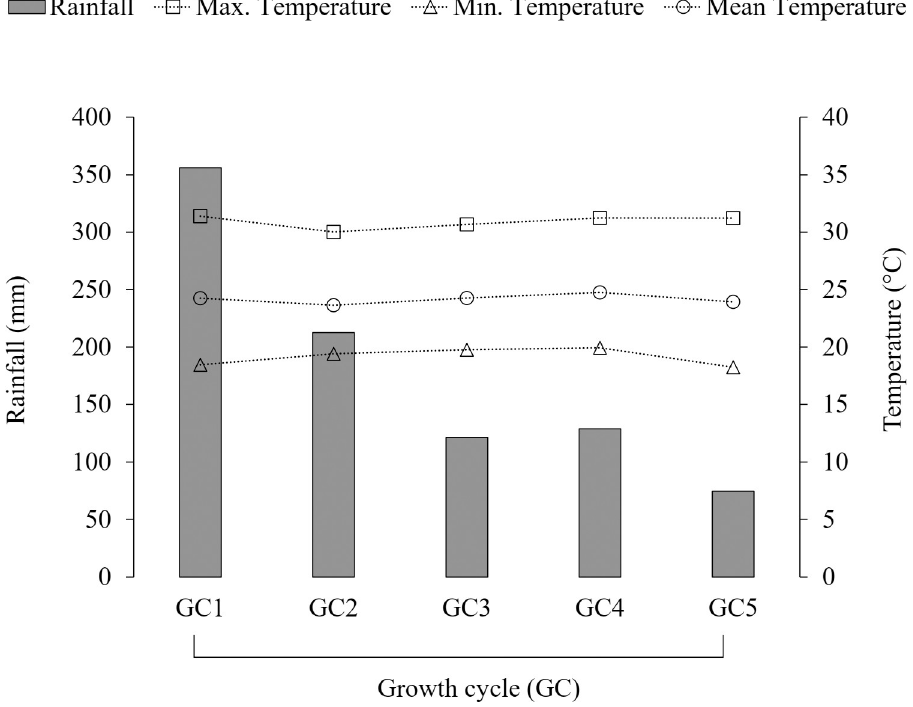
Fig 1. Cumulative rainfall and mean air temperatures (maximum, mean, and minimum) for five growth cycles (GC) in Jaboticabal, Brazil (Nov/2016-Mar/2017 and Dec/2017-Apr/2018).